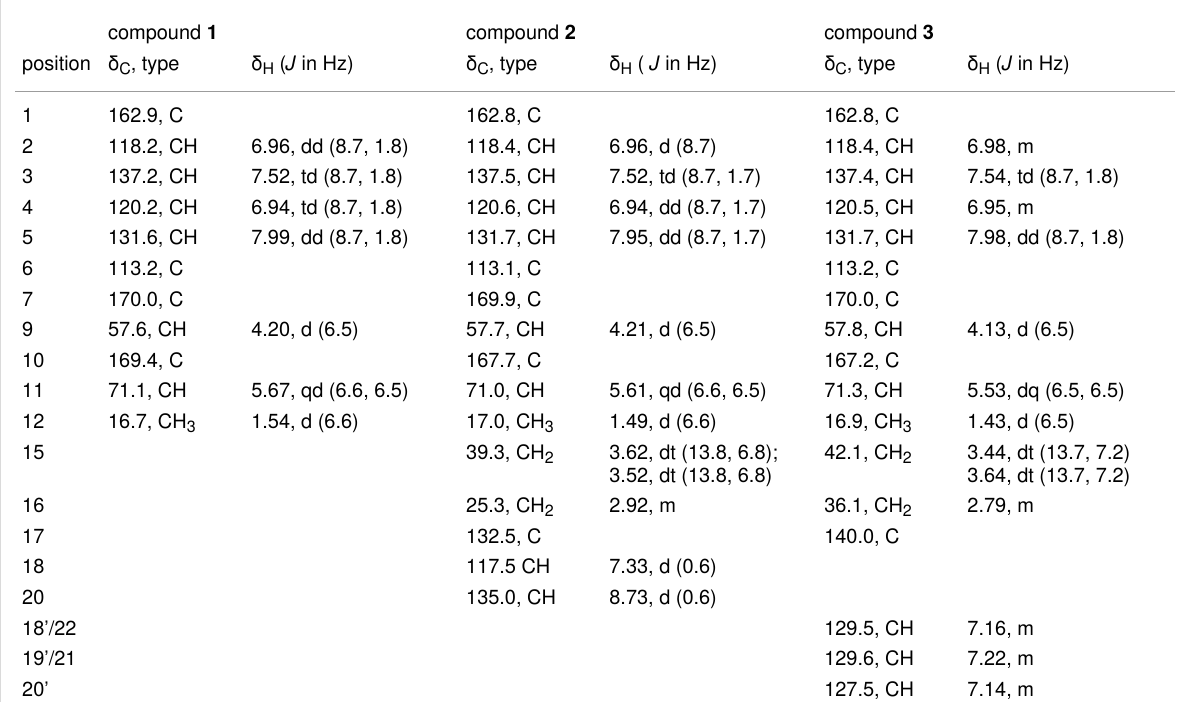
Table 1: 1 H and 13 C NMR data of pseudomonin A–C ( 1 – 3 ).